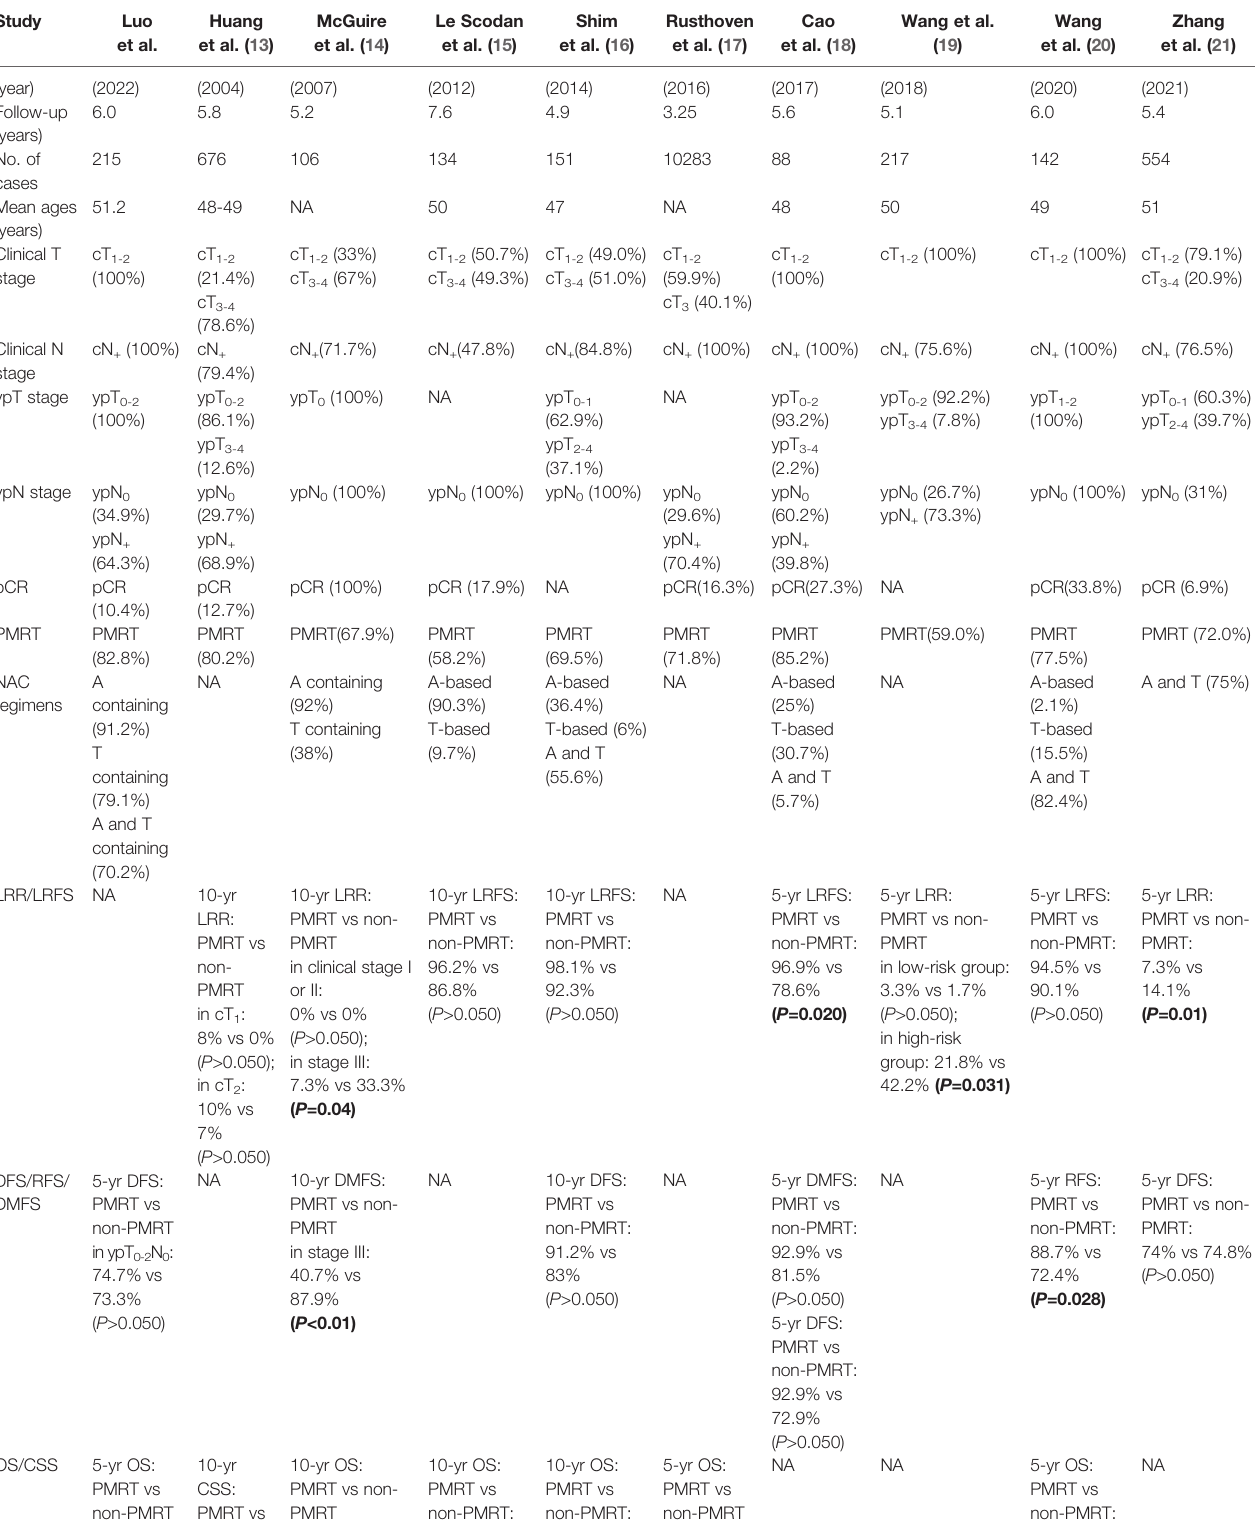
TABLE 6 | Previous studies analyzing the effects of PMRT after